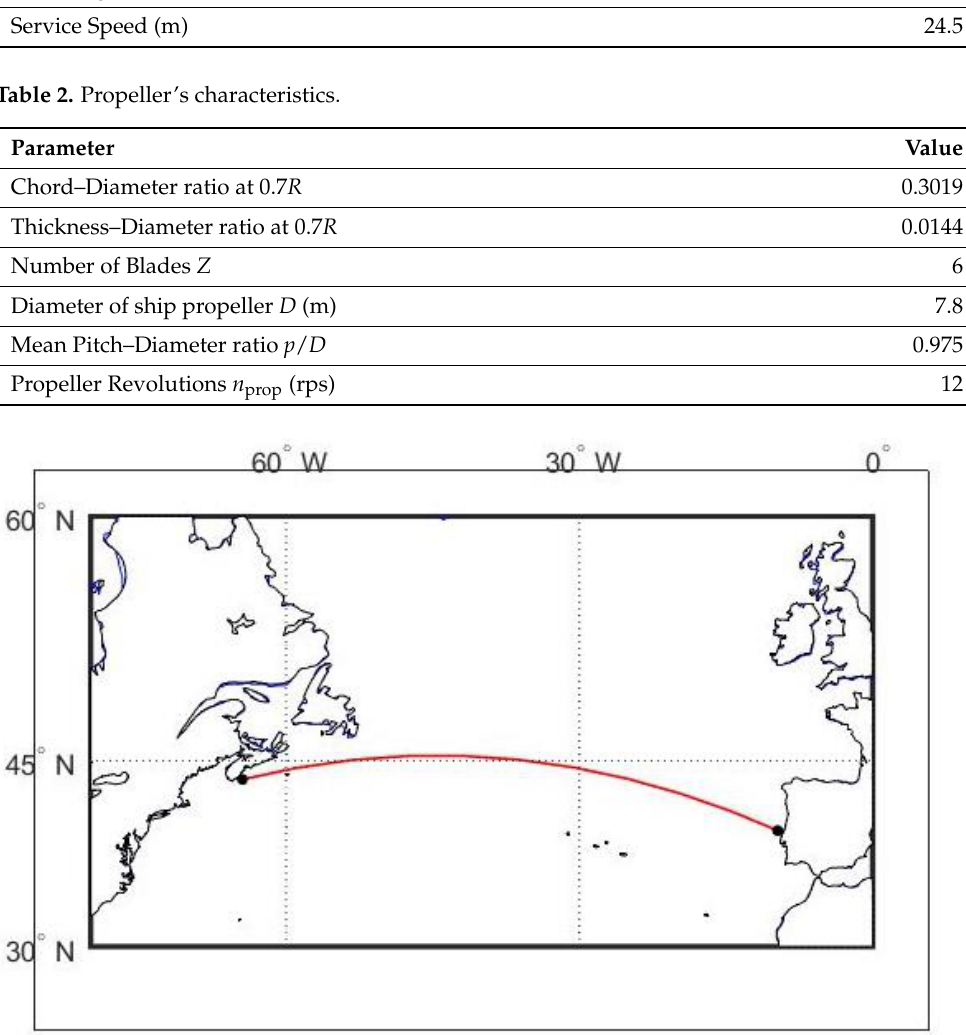
Figure 2. Orthodrome path for the chosen route between Europe and North America. Table 1. Containership’s characteristics.